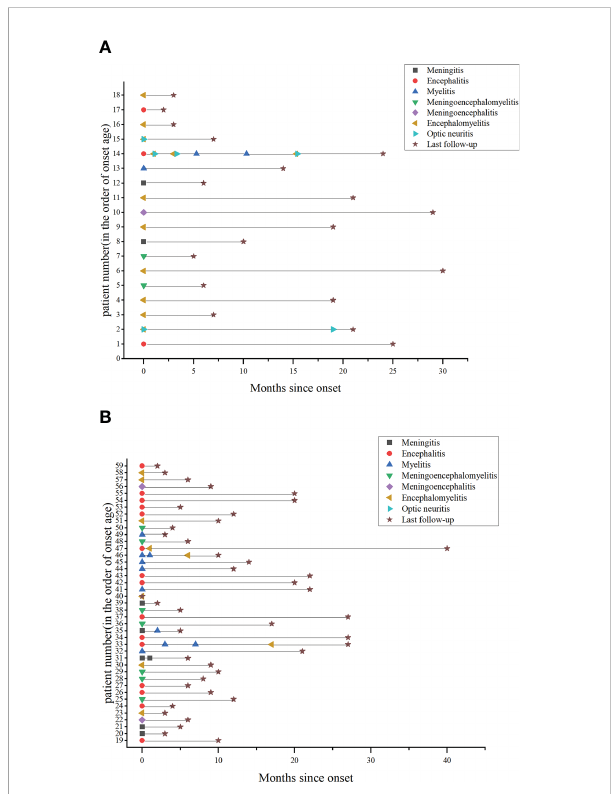
FIGURE 1 Clinical phenotype and disease course in patients with anti-GFAP